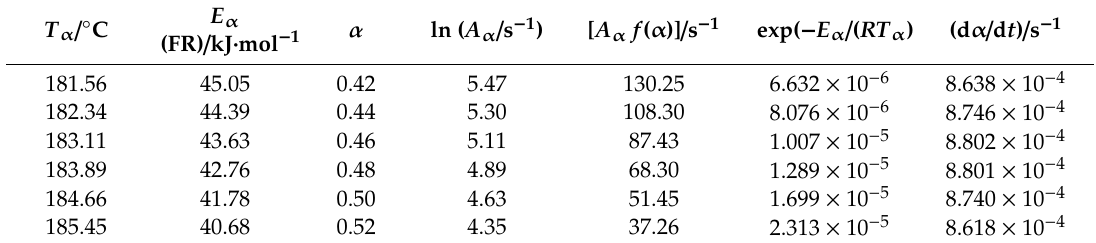
Figure 7. Red squares: variation of ln [ A α f ( α )] with α , green circles: variation of − E α / ( RT α ) with α , blue triangles: variation of (d α / d t ) computed as the product of [ A α f ( α )] by exp[ − E α / ( RT α )] with α . Table 1. Some values of the various terms used to identify a change in the rate-limiting step.